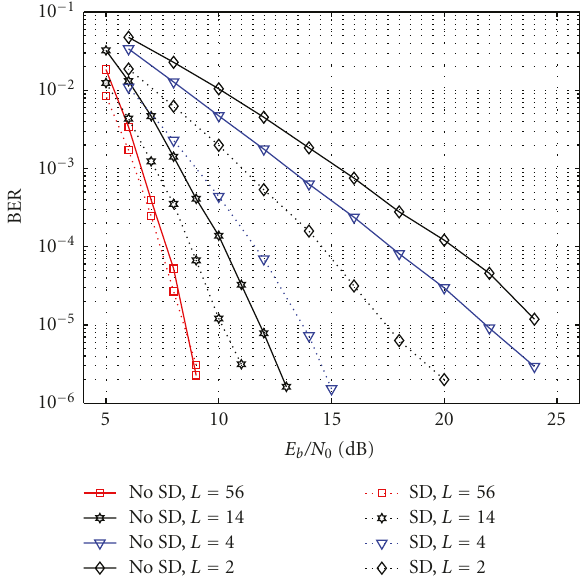
Figure 8: Performance comparison of distributed GLD codes with source-destination path (SD) and without source-destination path (No